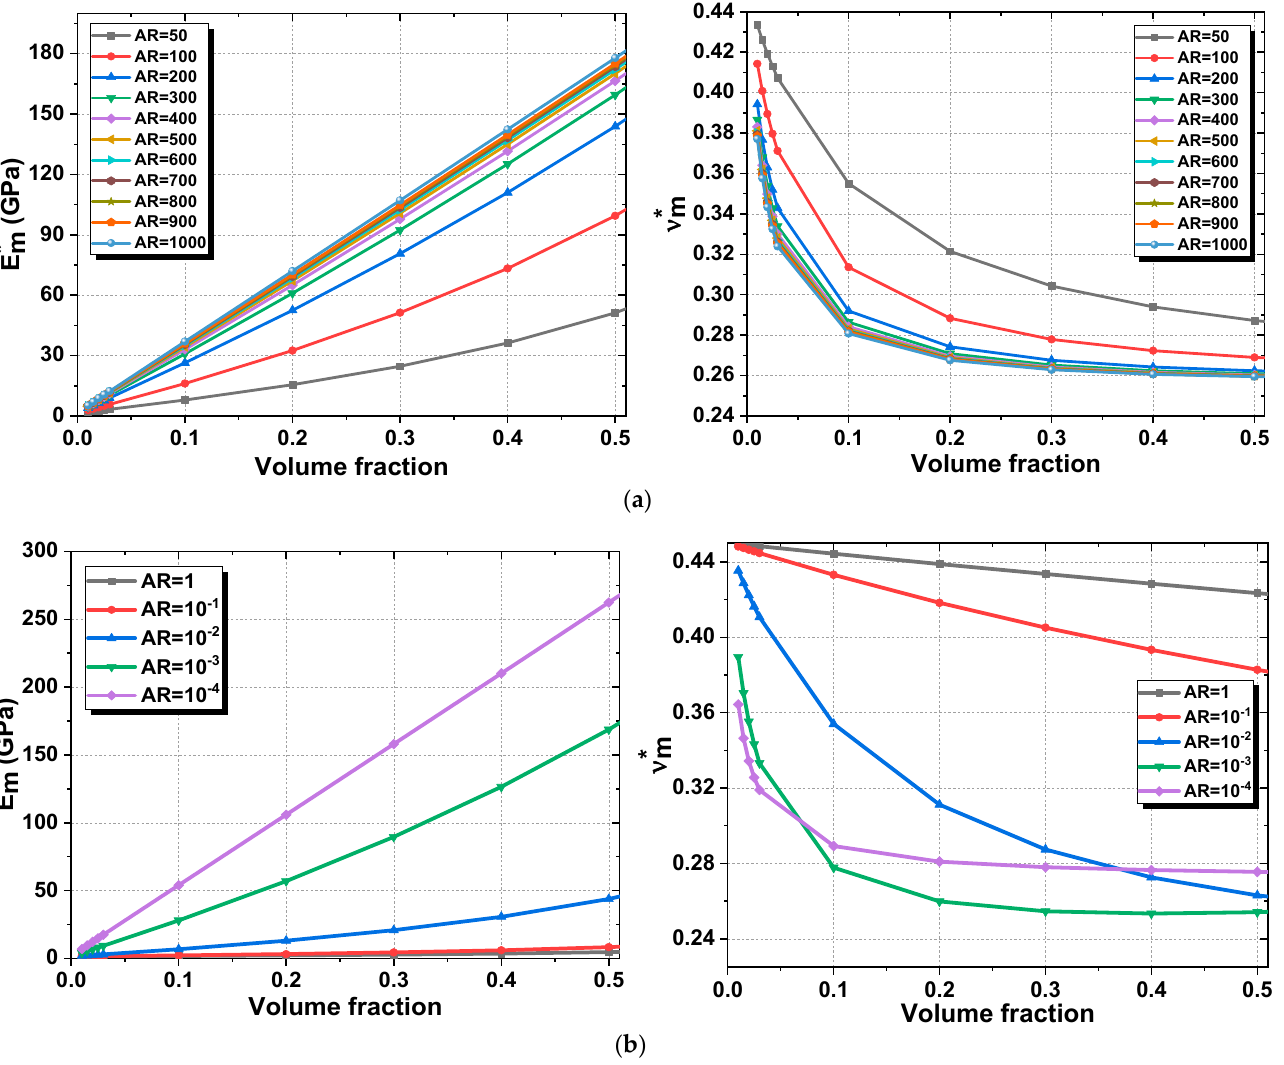
Figure 10. The effect of CNT/GNP aspect ratios on the effective elastic moduli of matrix using Digimat MF: ( a ) E ∗ m Young’s modulus for CNT-PP and ν ∗ m Poisson’s ratio for CNT-PP; ( b ) E ∗ m Young’s modulus for GNP-PP, and ν ∗ m Poisson’s ratio for